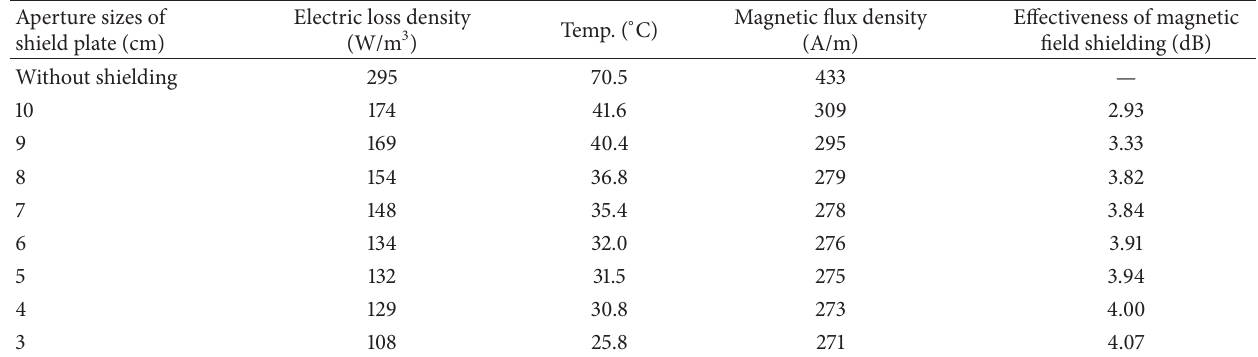
Table 2: Evaluating the electric loss density from changing the aperture